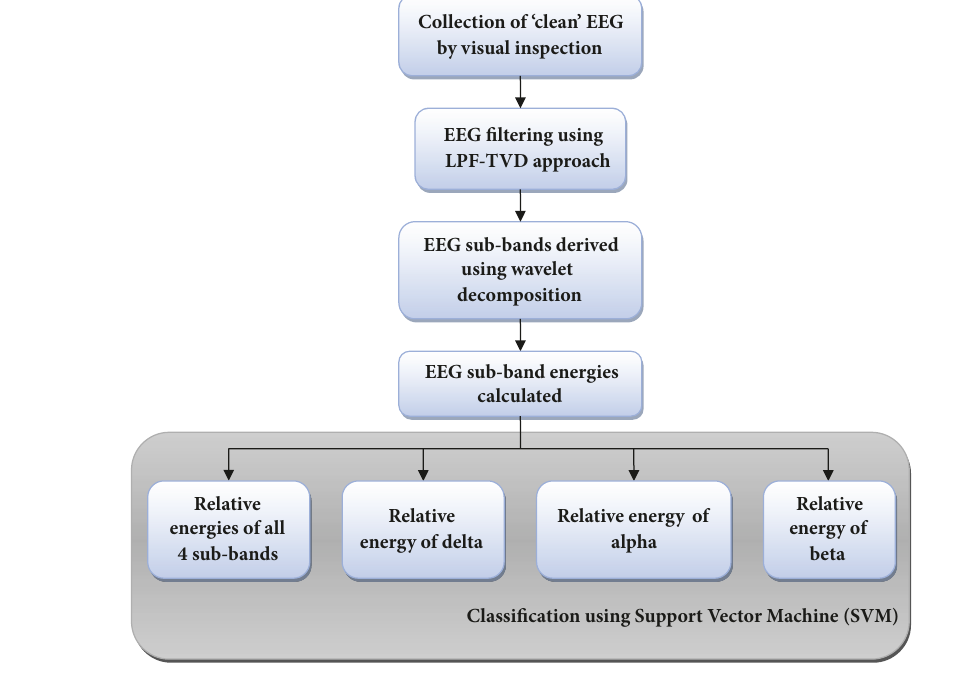
Figure 4: Flow diagram of the study.